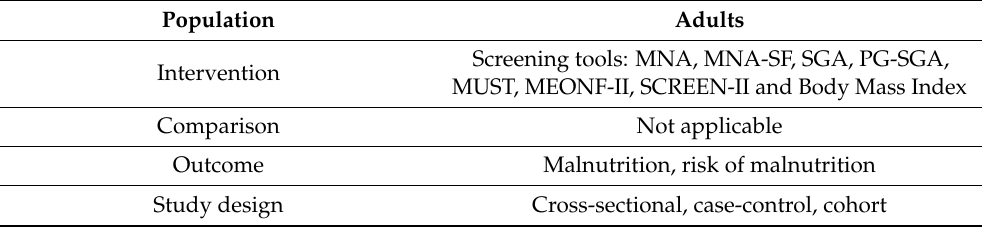
Table 2. PICOS structure’s criteria for study